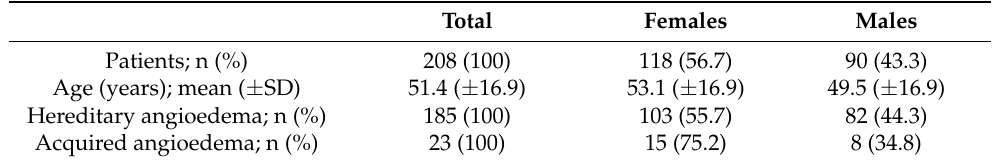
Table 1. Demographic data of patient population.